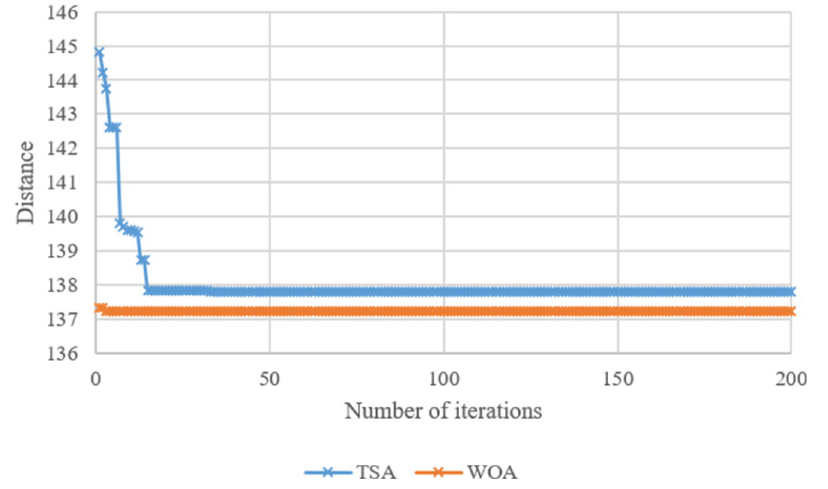
Fig 8. Search history of TSA and WOA for Case- 10